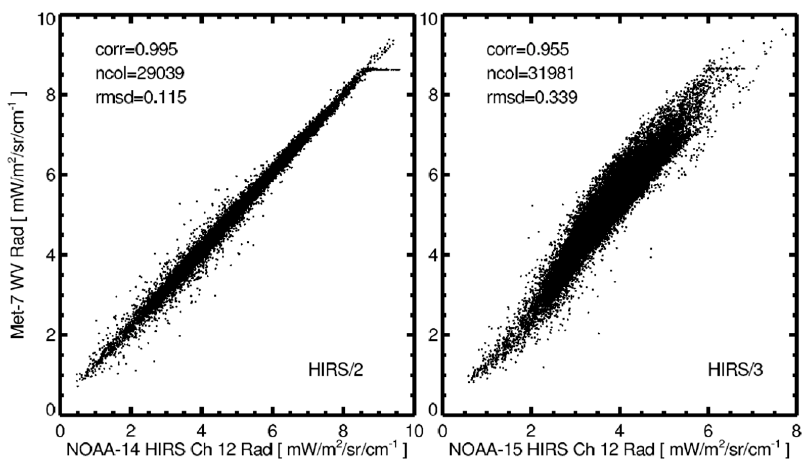
Figure 3. Impact of Channel 12 SRF changes between HIRS/2 and HIRS/3/4 on the collocation uncertainties with MVIRI WV channel. Collocations are for January 2003, see text for more details.